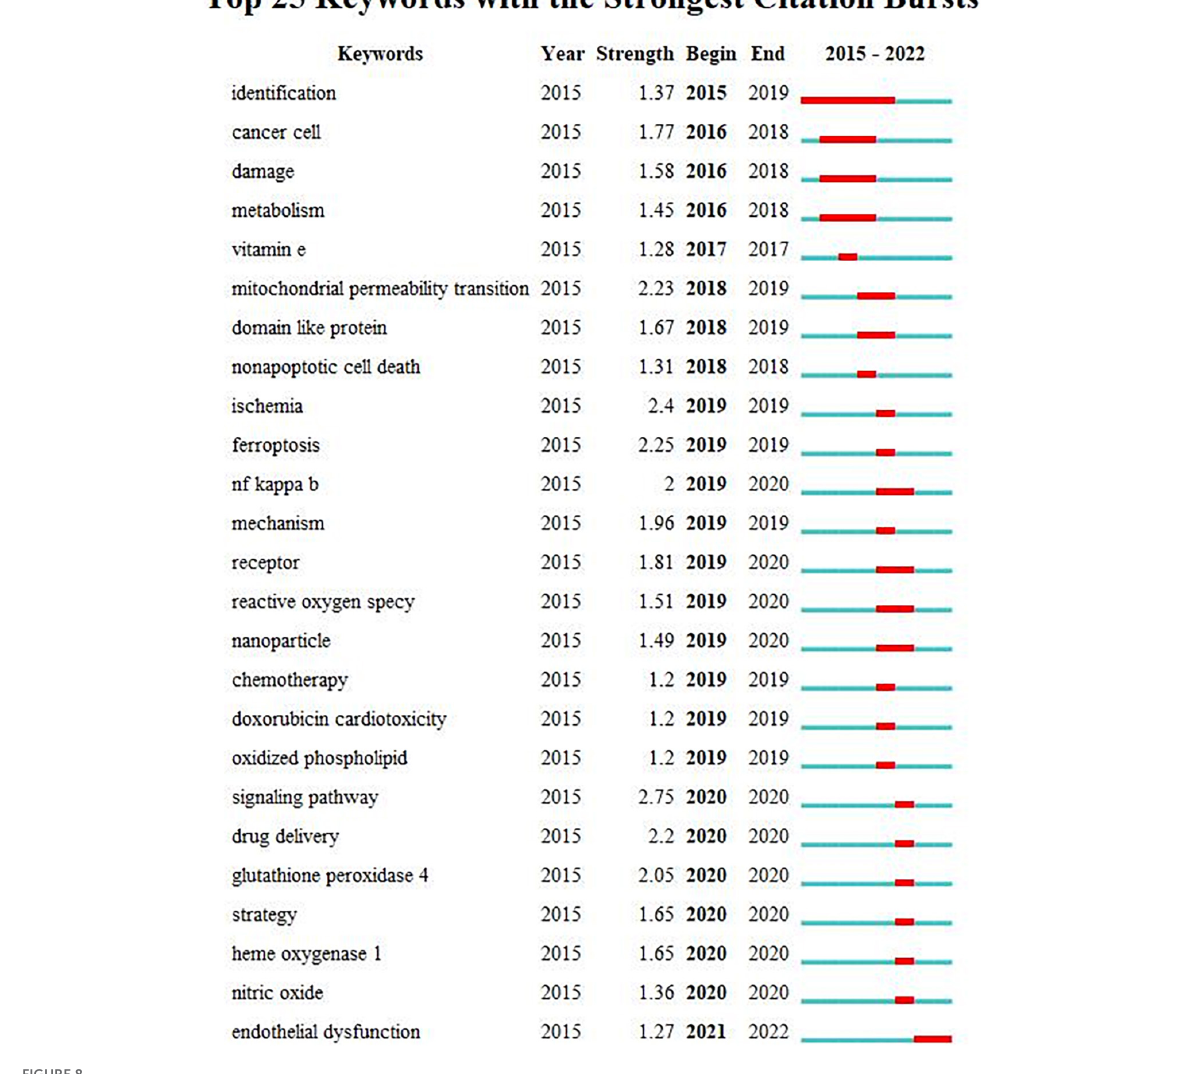
FIGURE8 Top 25 keywords with the strong citation